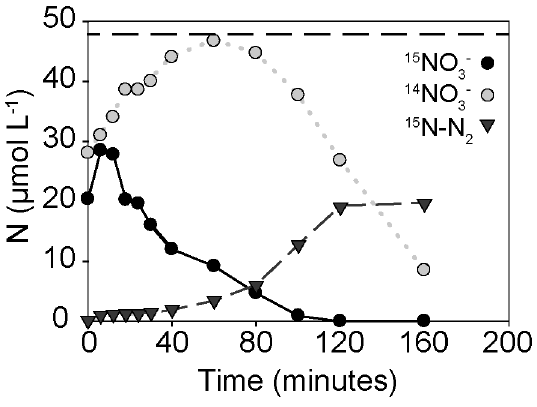
Figure 4. Exchange of 15 NO 3 2 and 14 NO 3 2 over time in summer incubations. The dashed line indicates the initial amount of 15 NO 3 2 added to the incubation